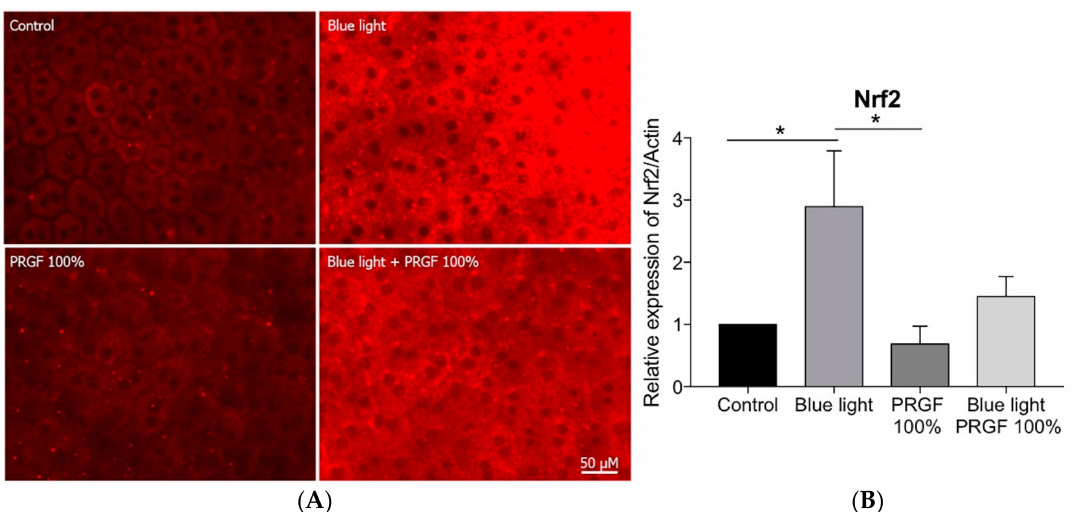
Figure 11. ( A ) RPE immunocytochemistry for Nrf2 (red) ( n = 4), results showed that blue light increased Nrf2 staining, PRGF 100% combined with blue light resulted in reduced intensity of staining compared to blue light results; ( B ) Nrf2 gene expression was stimulated by blue light while PRGF 100% reduced it. Statistical analysis: One-way ANOVA, Tukey multiple comparison test, and * p < 0.05. Scale = 0.5 µ